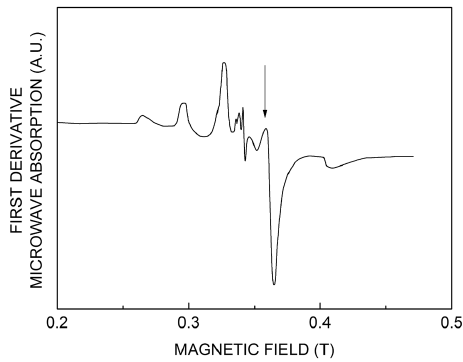
Figure 2. EMR spectrum of a BaTiO